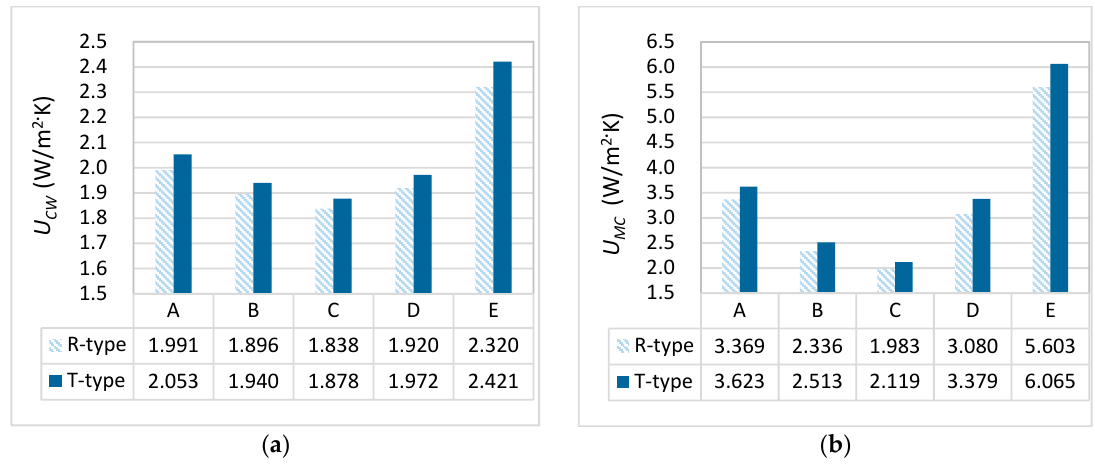
Figure 6. Comparison of U CW and U MC according to head profile and rabbet space. ( a ) Overall thermal transmittance of the curtain wall; and ( b ) thermal transmittance of the central mullion.